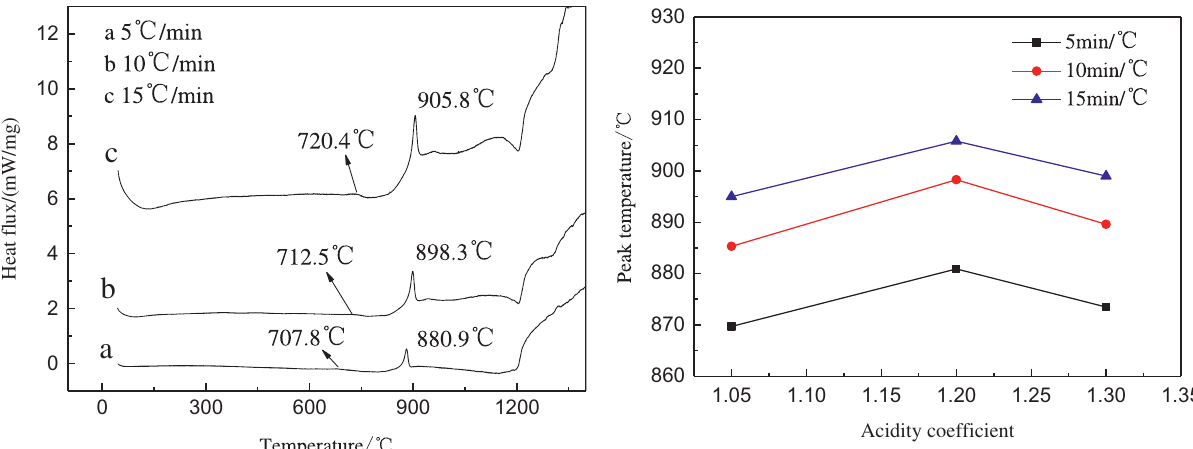
Figure 6: Effect of acidity coefficient on the crystallization